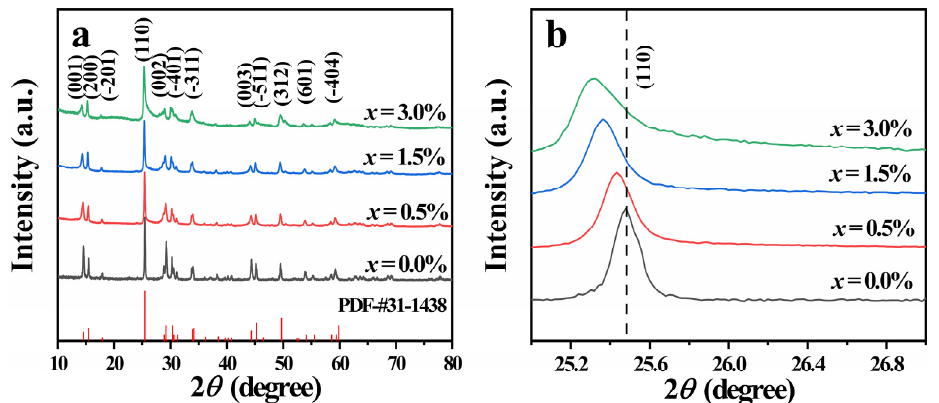
Figure 2. ( a ) XRD patterns of Zn-VO 2 (B) samples with different x values; ( b ) magnified patterns around 2 θ = 25°.